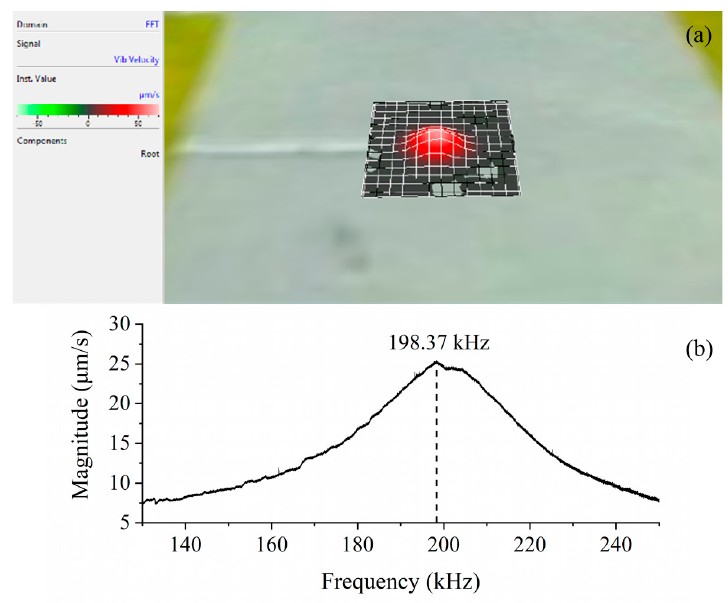
Figure 13. The frequency response analysis of proposed PMUT. ( a ) The flexural vibration mode shape; ( b ) the frequency response curve.